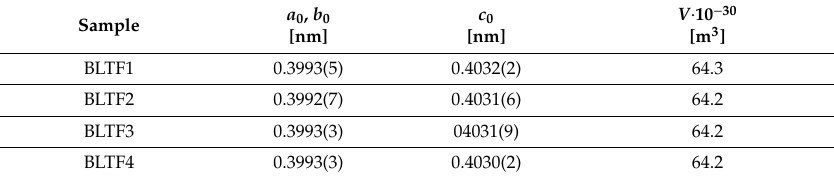
Table 1. Lattice parameters and cell volume of elementary BLTF